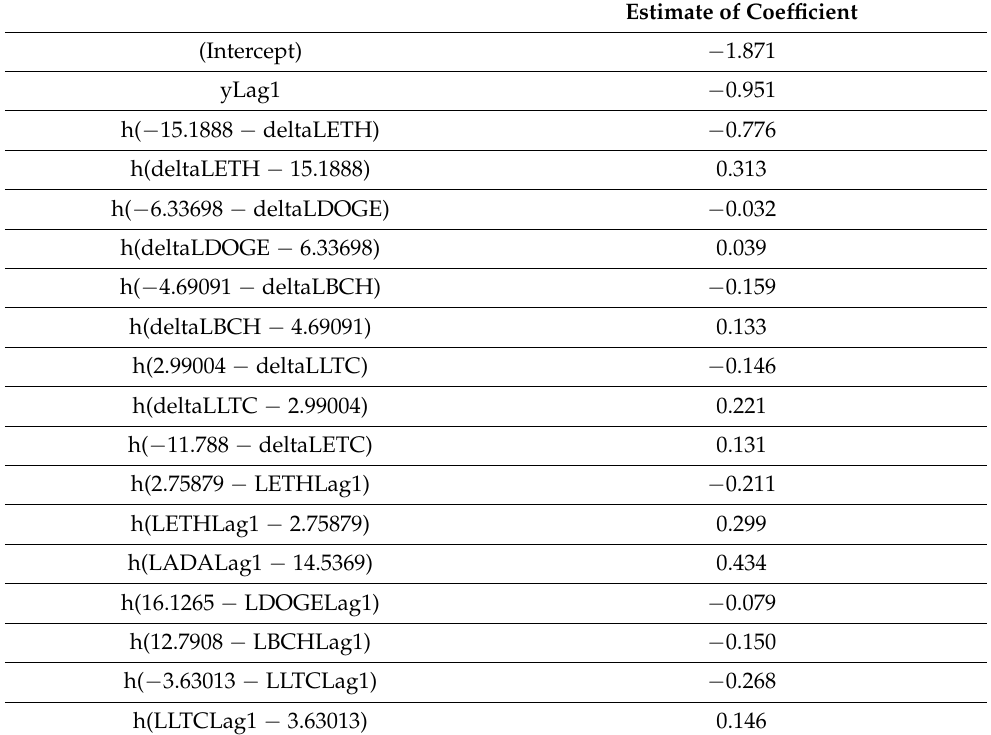
Table 7. Summary for model 2 with training